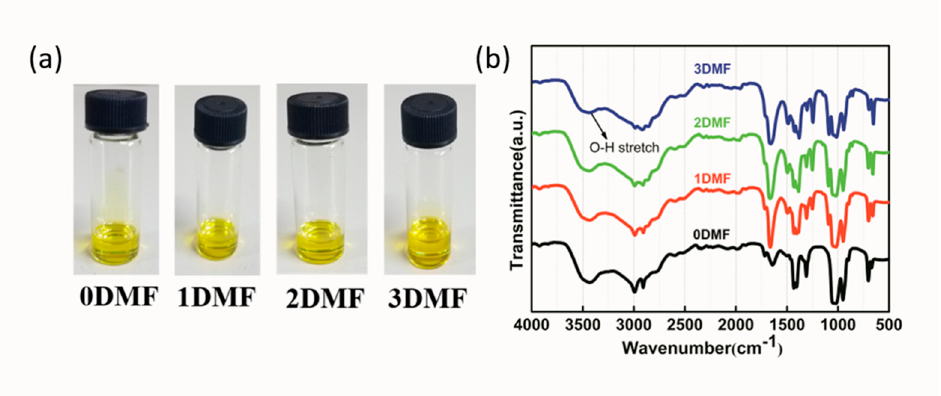
Figure 1. ( a ) Different perovskite precursor solution photos; ( b ) Fourier Transform Infrared (FTIR) transmittance spectra of precursor solutions.